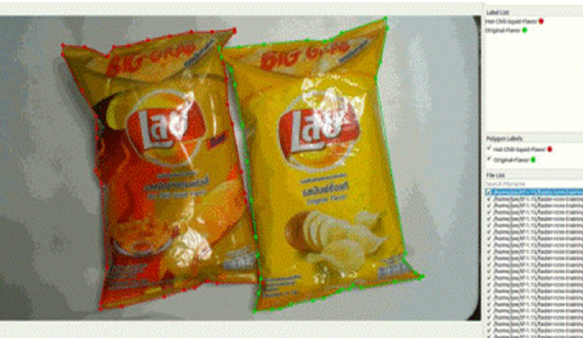
Figure 7. Marking objects with Labelme. Table 2. Items in the Snacks database.